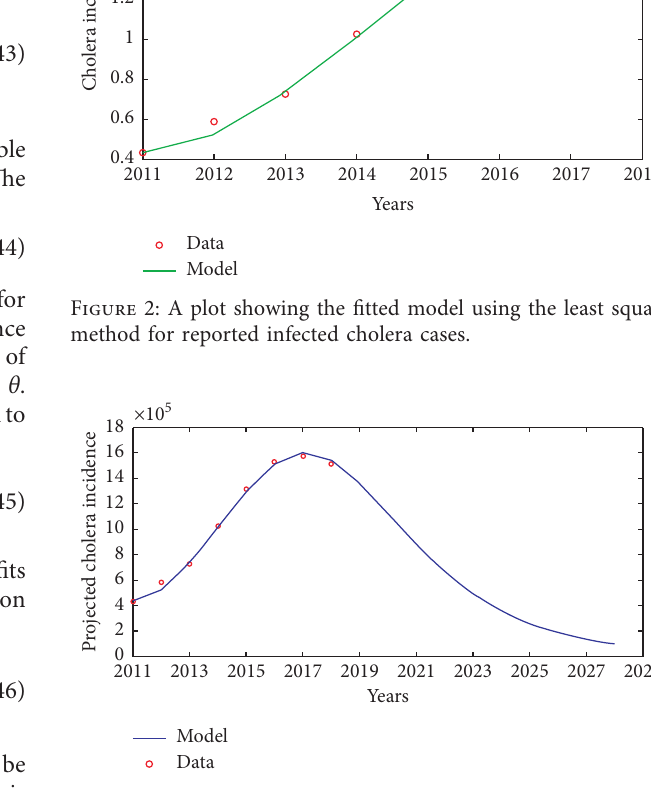
Figure 3: A plot showing the projection of cholera cases fitted to the actual data of the model. Parameters used are defined in Table